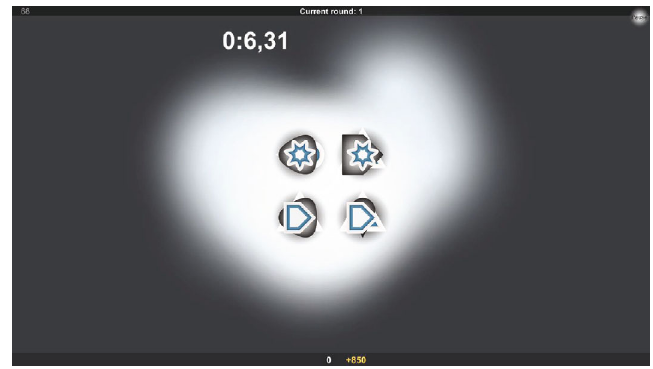
Figure 5: Screenshot of a hexlogic computer